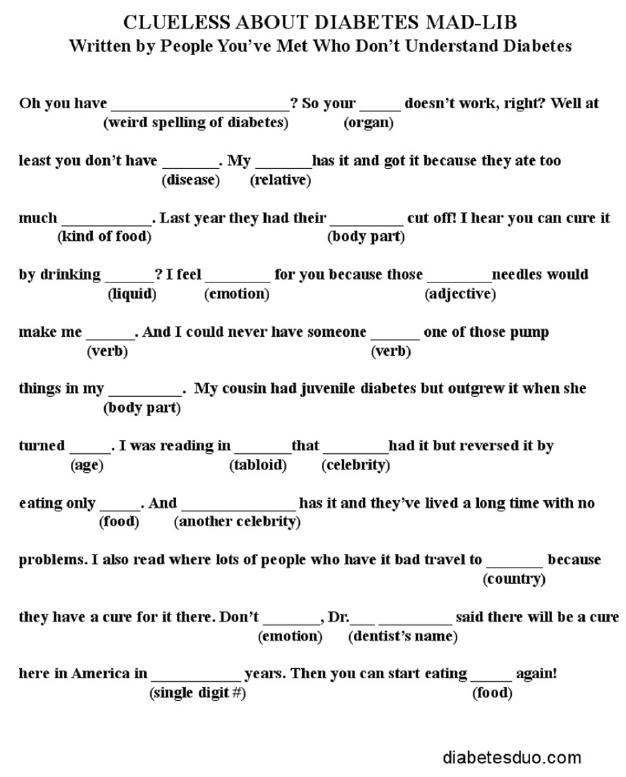
Figure 4. Sample Mad Lib providedin